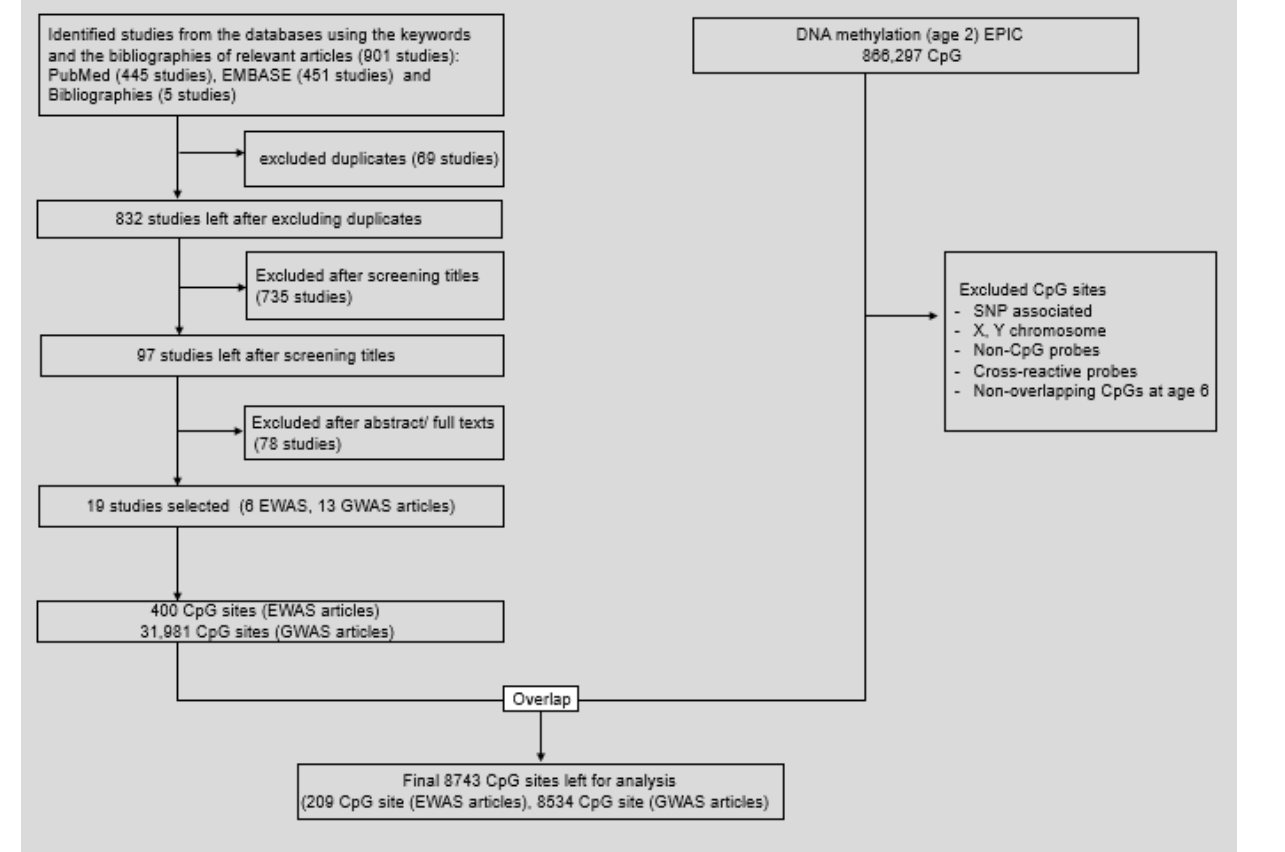
Figure 1. Workflow for model building for selecting cognitive abilities based on a systematic literature review.